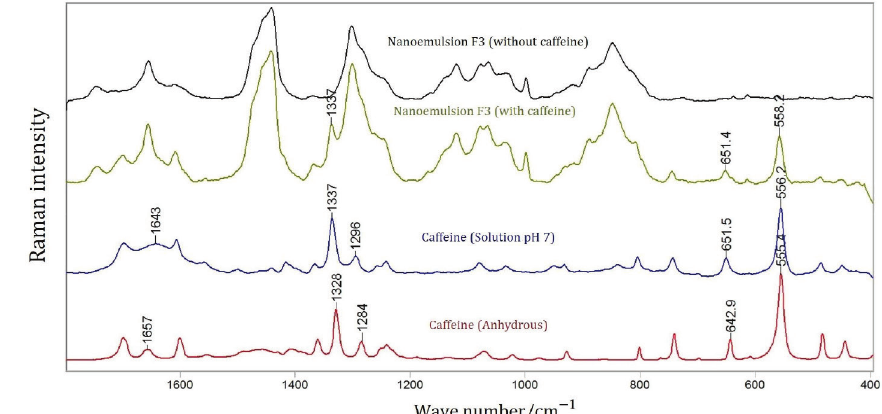
FIGURE 3 – Comparison of the Raman spectrum bands of caffeine in solution and anhydrous with the nanoemulsion F3 in the presence or absence of the